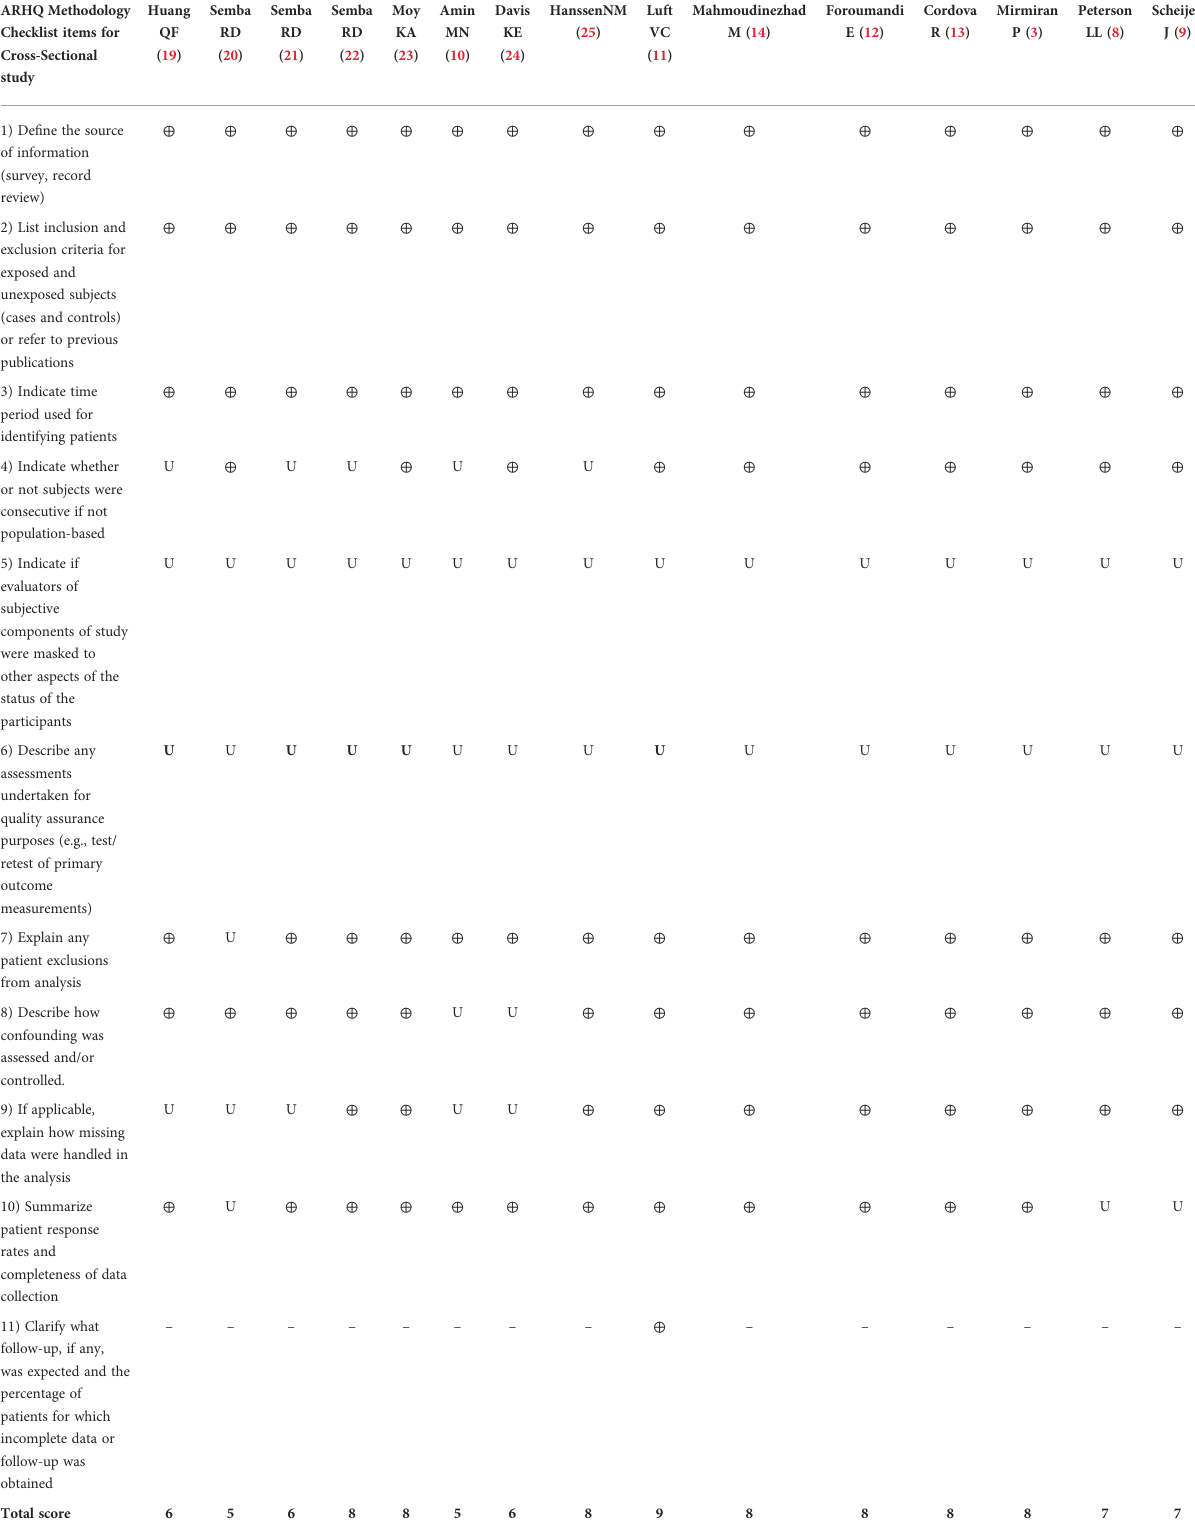
TABLE 2 Agency for Healthcare Research and Quality (AHRQ) checklist to assess quality of the cross-sectional studies. ARHQ Methodology Checklist items for Cross-Sectional